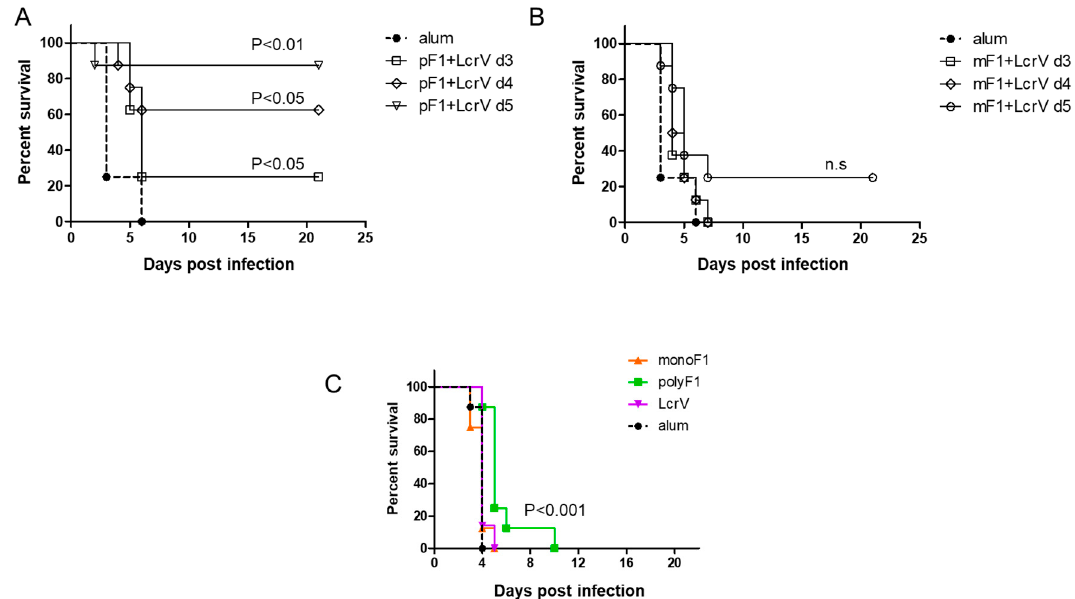
Figure 3. The importance of the polymeric structure of F1 in affording rapid onset of protection against pneumonic plague. ( A ) Survival curves of C57BL/6 mice ( n = 8) vaccinated with polymeric F1 and LcrV (80 µg each/mouse) and with ( B ) monomeric F1 and LcrV (80 µg each/mouse) 3 days (open squares), 4 days (open diamonds), and 5 days (open circles) before an intranasal challenge with Y. pestis Kim53 (10 LD50). Mortality of control, AlOH-vaccinated animals ( n = 4) is shown by a thick dashed line and closed circles. ( C ) Survival of the mice vaccinated with monoF1, polyF1, or LcrV (80 µg/mouse) 4 days prior to the challenge indicated above. p values calculated by the log-rank test toward control AlOH-vaccinated animals are shown. n.s. = nonsignificant.